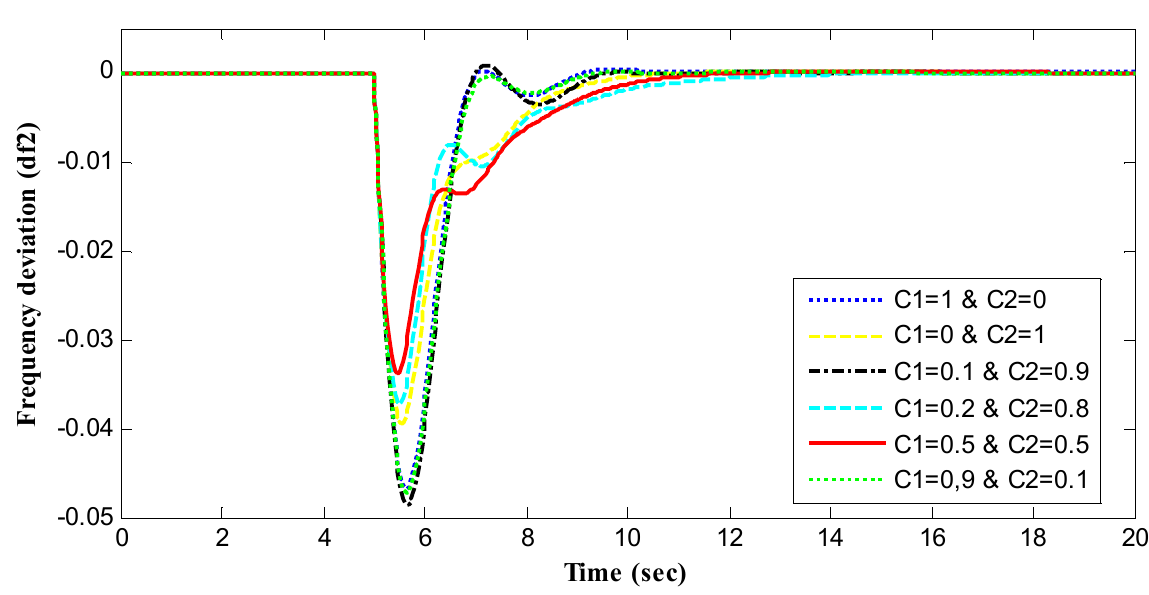
Figure 9. Frequency deviation ∆ f 1 for area1 using the proposed IB-WGFF.